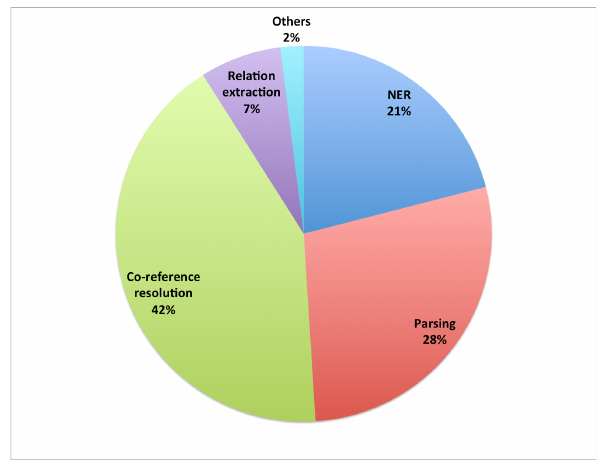
Figure 3 A processing time of major tasks for text extraction